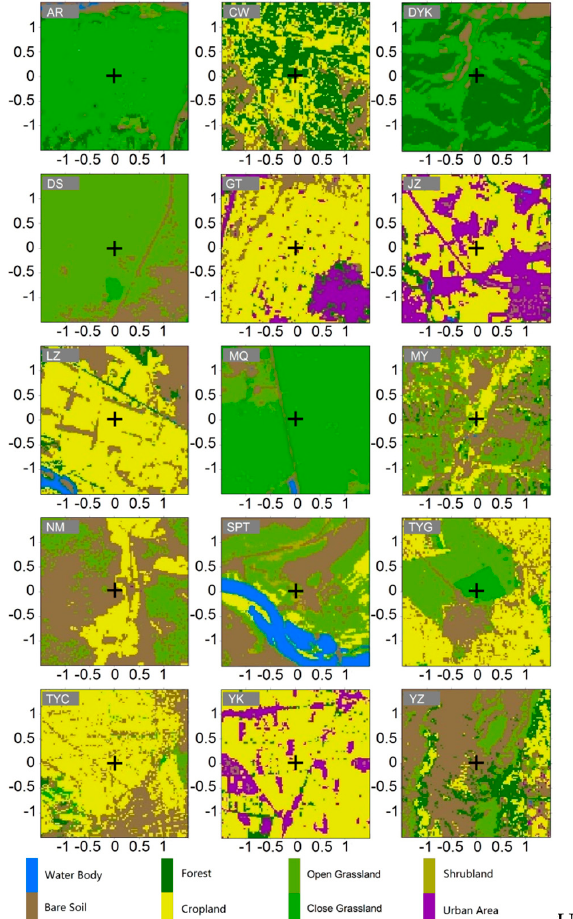
Figure 7. Land cover classification of the 15 sites at a 30 m resolution over grid area of 3 km × 3 km centered at individual flux sites.